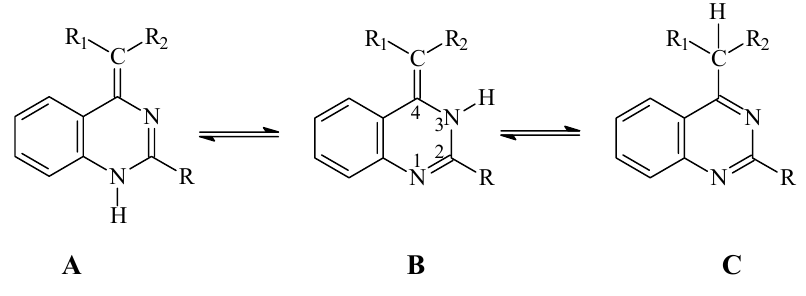
Figure 2. Possible tautomeric states for compounds 1 and 2